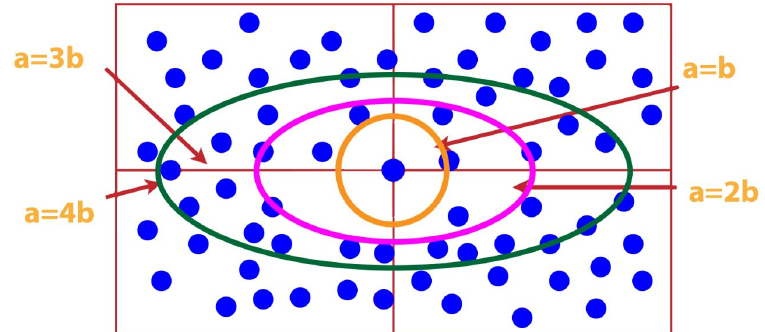
Figure 2. Multiple